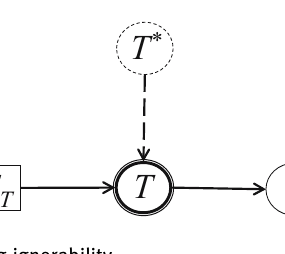
Figure 7 results on “ eliminating ∗ T ” from Figure 6: that is to say, the conditional independencies represented in Figure 7 are exactly those of Figure 6 that do not involve ∗ T . In this case, the only such property is ( 21 ) .